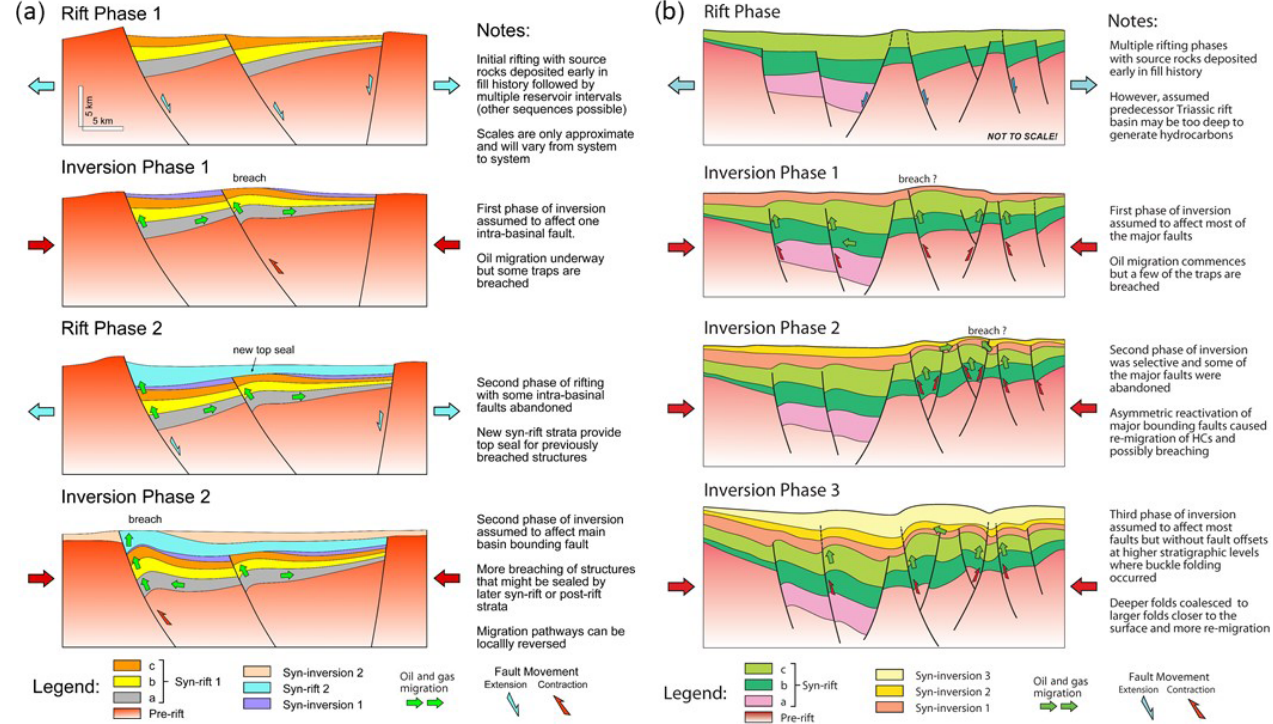
Figure 14. (a) Schematic illustration of some of the possible effects of superimposed, alternating phases of extension and inversion on a rift basin. For simplicity two inversion events are shown affecting different faults, which is commonly observed in the Western Desert of Egypt but will not always be the case. (b) Schematic illustration of a basin in which early extension is followed by multiple phases of inversion. The transect is largely based on observations made in the NW Black Sea, which experienced at least four distinct inversion